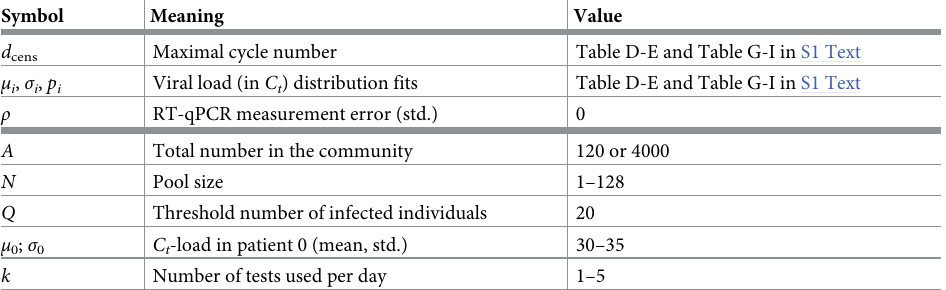
Table 2. Table with standard parameter values (with std. the abbreviation of standard deviation).